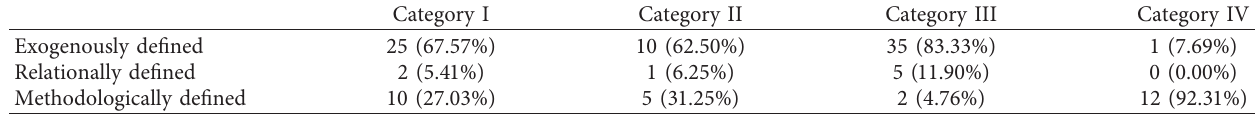
Table 6: Distribution of publications by boundary specification methods and categories of network analysis.